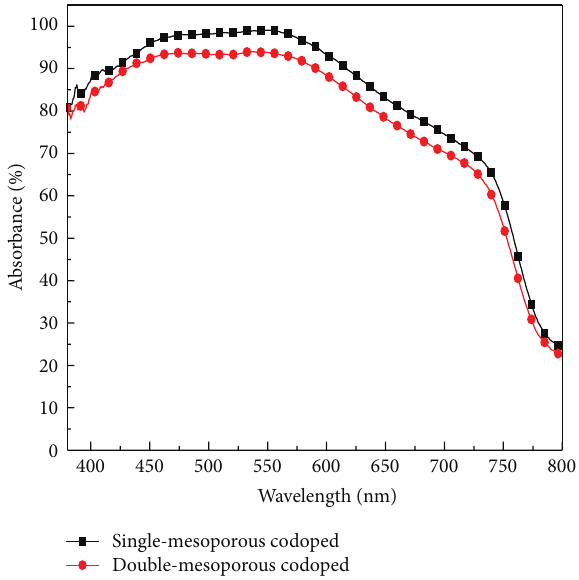
Figure 12: The UV-vis spectra of the device based on single- and double-mesoporous